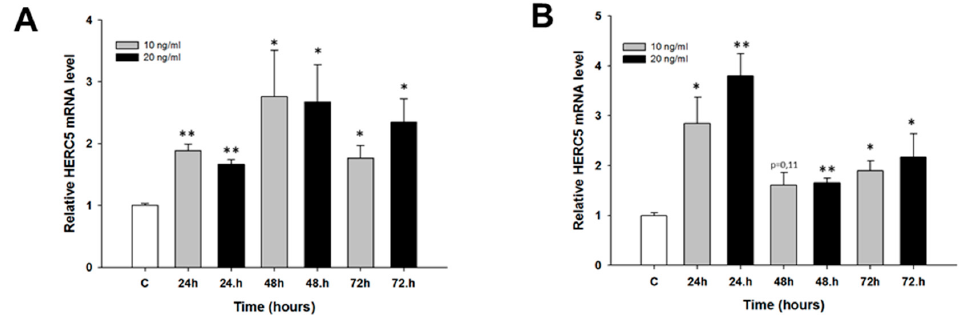
Figure 9. Expression analysis of the HERC5 gene in: W1 ( A ); and A2780 ( B ) ovarian cancer cell lines. The figure presents the relative gene expression in TOP-treated cells (grey and black bars) with respect to the untreated control (white bars), assigned as 1. The values were considered significant at * p < 0.05 and ** p < 0.01.